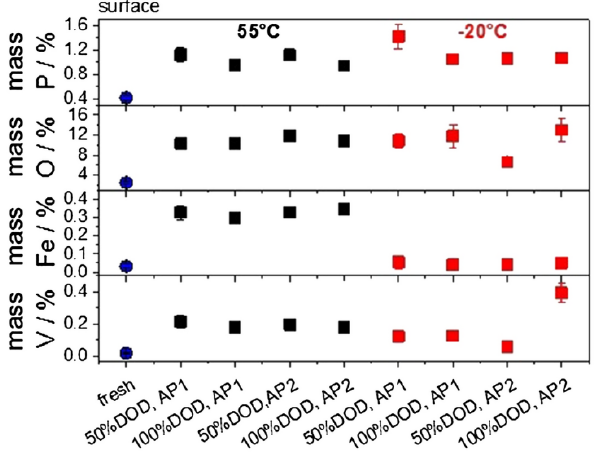
Figure 14. EDX analysis on anode surfaces [64].